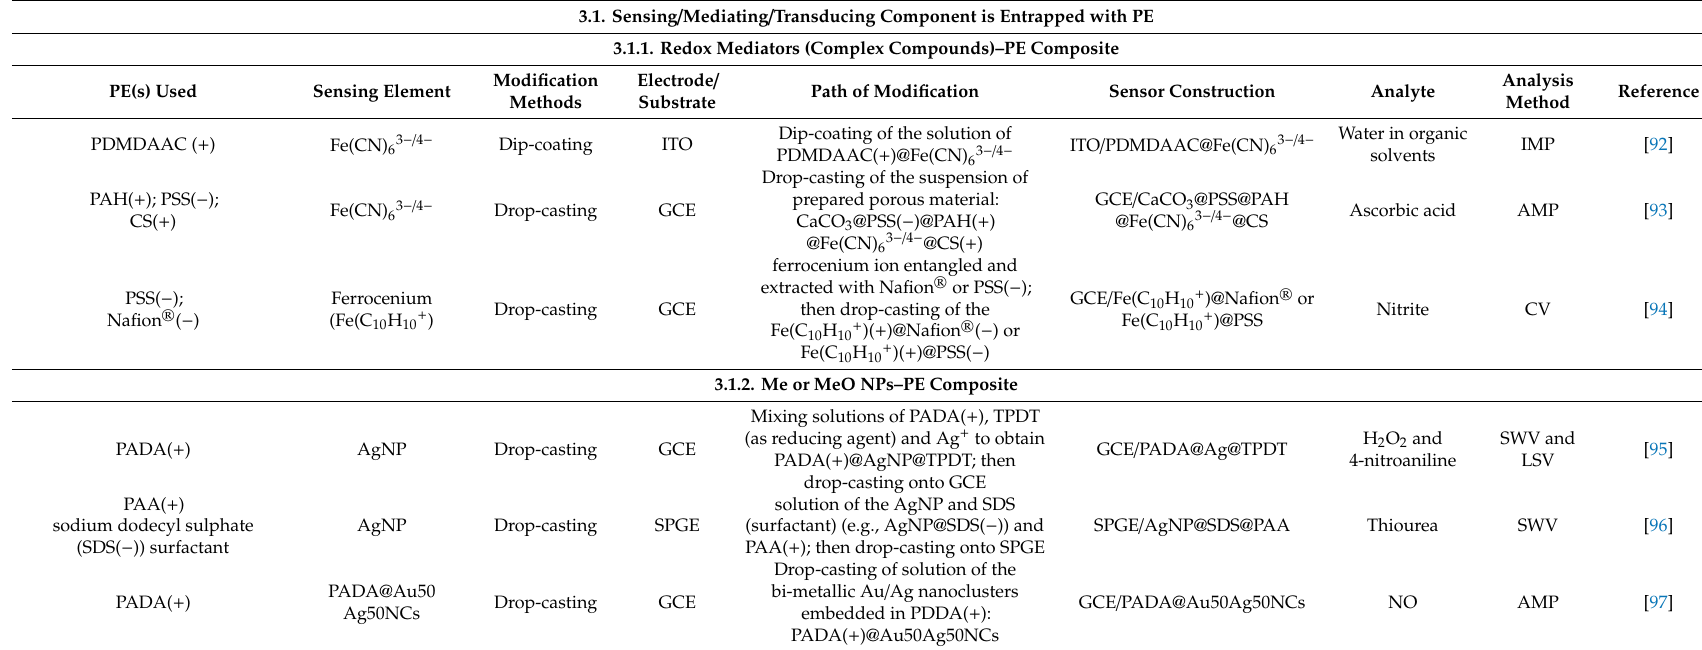
Table 5. Summary of electrochemical sensors based on sensing layers obtained by drop-casting or dip-coating methods in a simple architecture: entrapping a sensing material (or redox mediator) in a polyelectrolyte